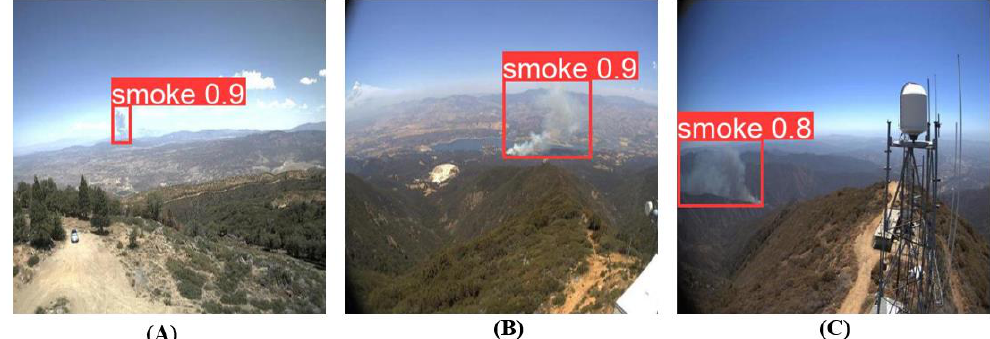
Figure 9. YOLOv5l detection areas results. ( A ) Far. ( B ) Medium. ( C ) Close.